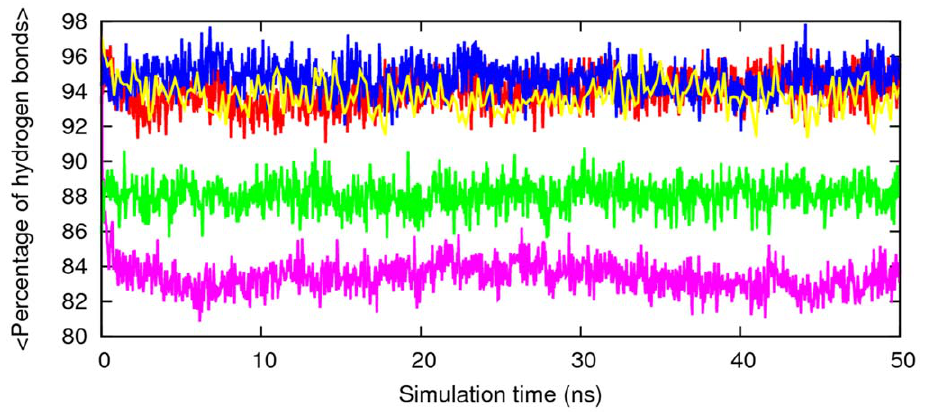
Figure 9. Percentage of hydrogen bonds as a function time with respect to the energy minimized structure of A b segmental polymorphic models. Red, 16–21P; green, 16–21AP; blue, 27–32; pink, 35–42; cyano, 30–42.